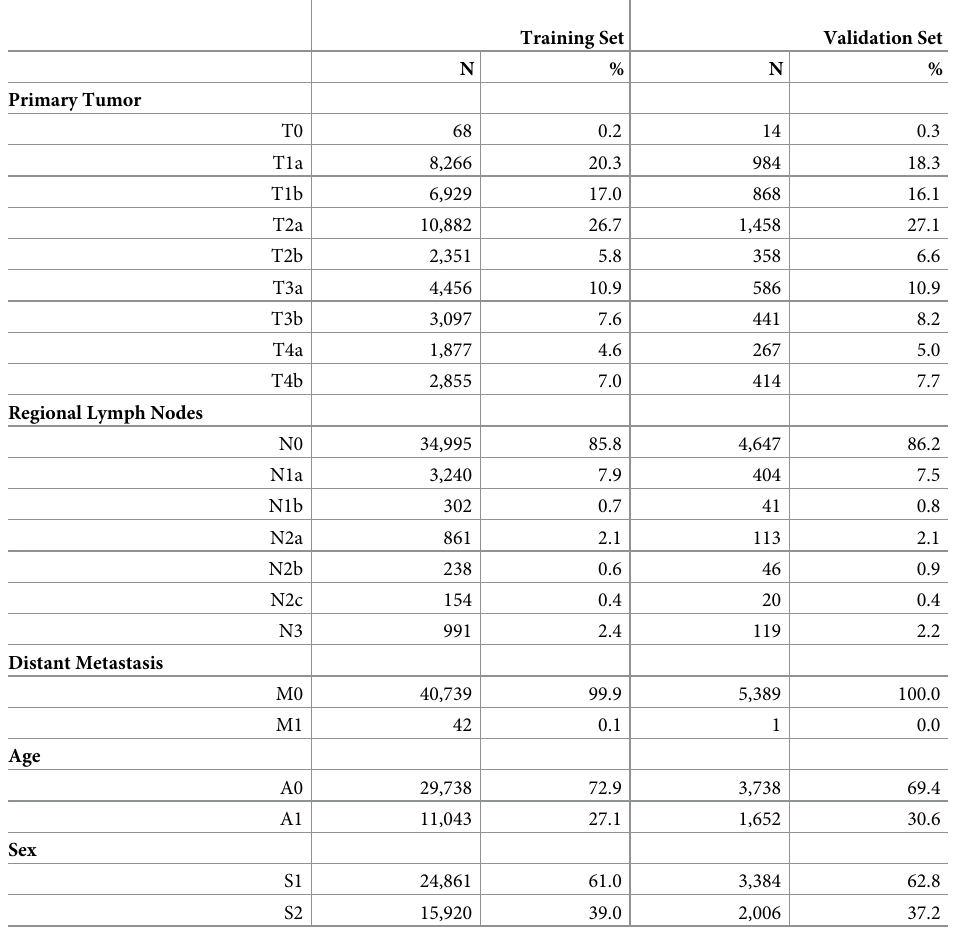
Table 1. Clinical and demographic characteristics of the data.